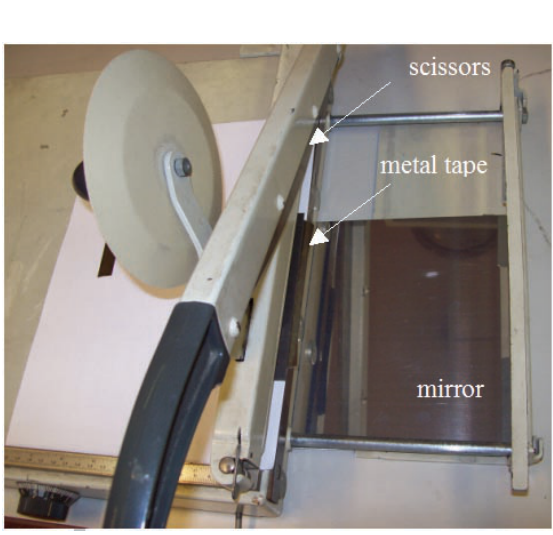
Figure 2. Shear for sample preparation. The mirror enables the identification of the dorsal marks to ensure identical co - planar sample